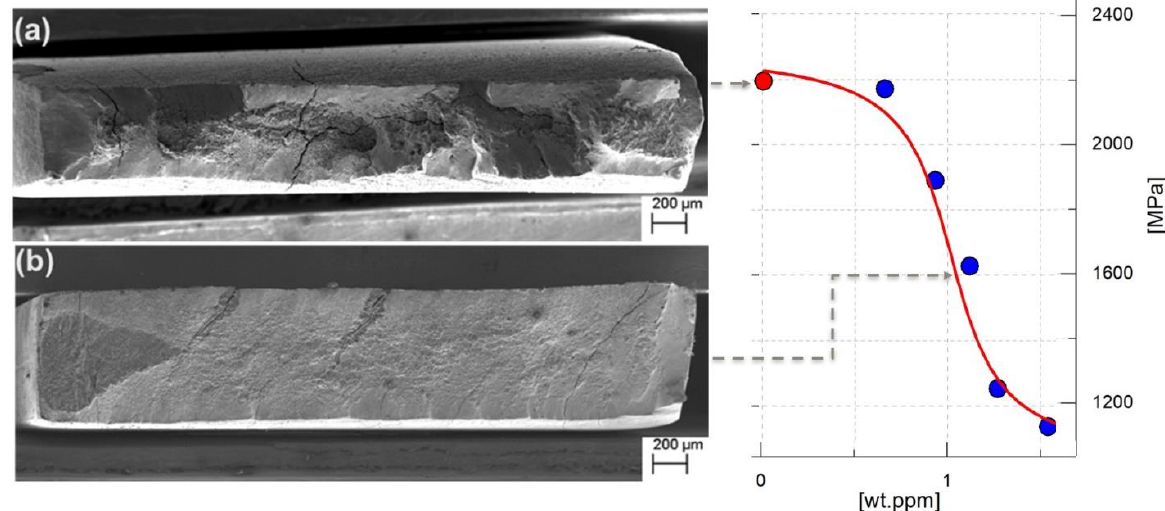
Figure 10. Fracture surface of the tensile specimens: ( a ) Tested in air without hydrogen charging; ( b ) electrochemical hydrogen charged to 1.1 wt.ppm.